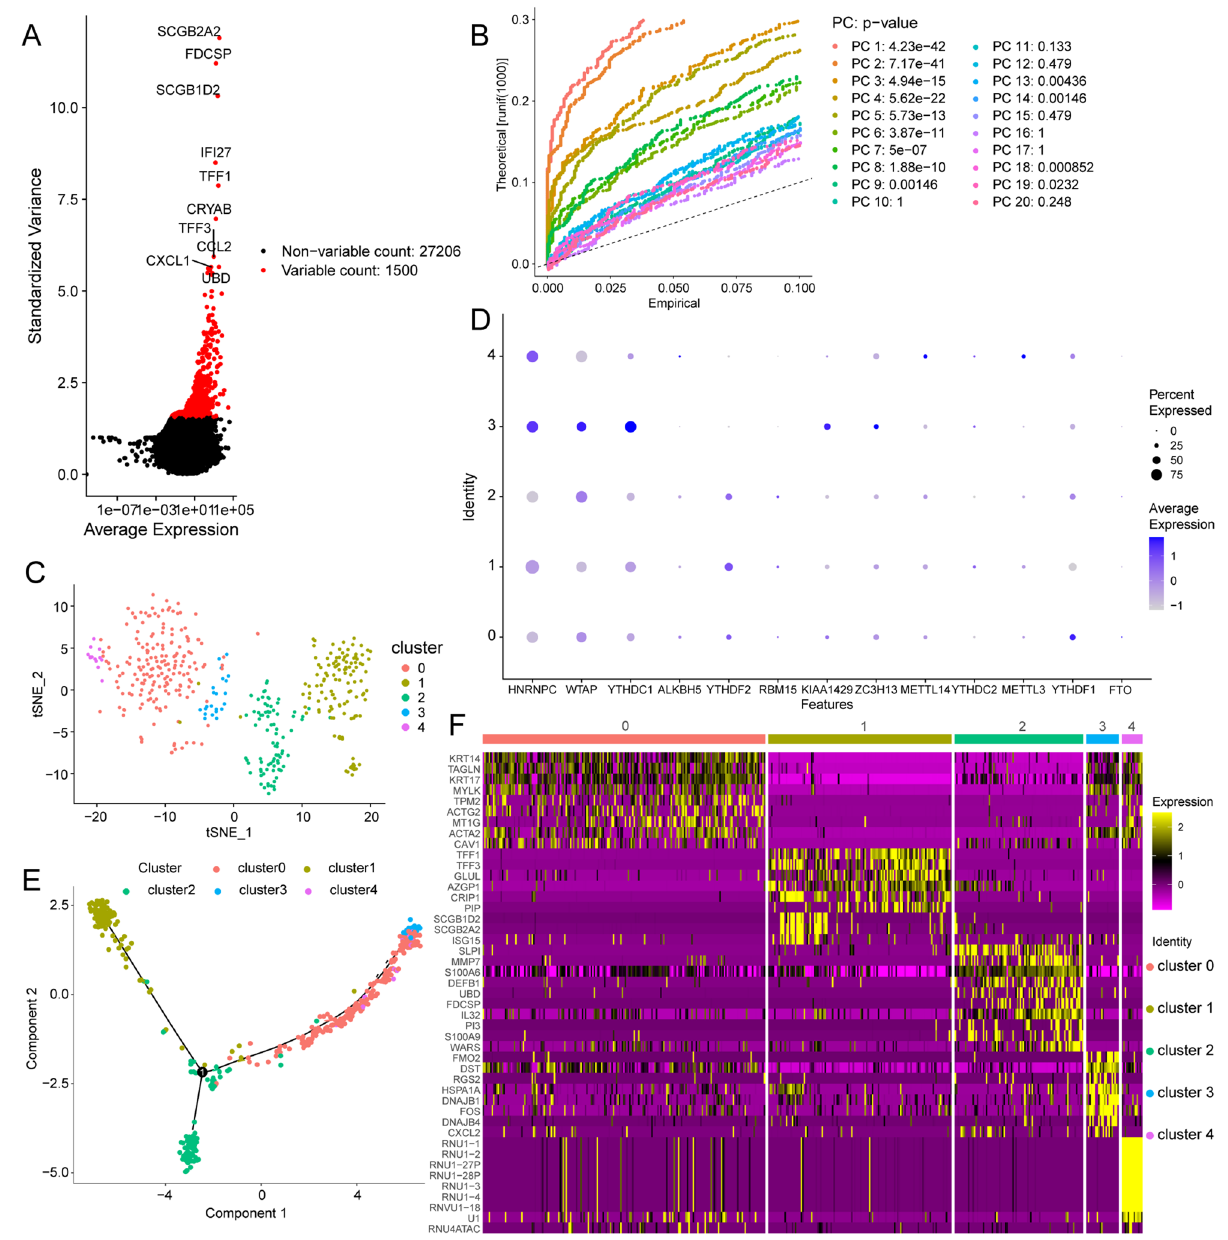
Figure 7. Single-cell sequencing method reveals expression patterns of m6A regulators. ( A,B ) Gene filtering and PCA clustering of gene expression matrix. ( C ) t-SNE projections of IBC tissue. ( D ) Regulation mode of m6A regulators in various invasive breast cancer (IBC) clusters. 0–4 on the Y axis indicate different clusters. ( E ) Cell trajectory analysis of IBC clusters. ( F ) The heatmap shows the marker genes in each